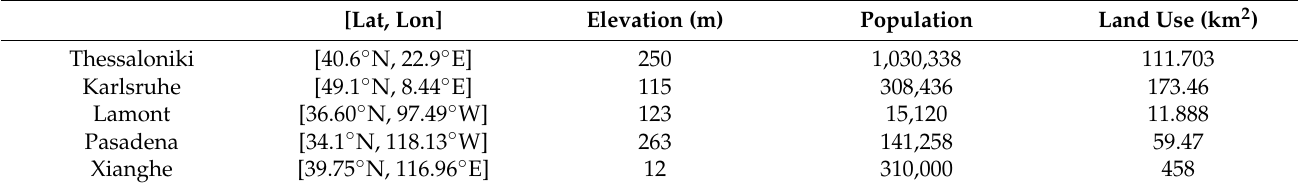
Table 2. Site features of Pasadena, Lamont, Karlsruhe, Thessaloniki and Xianghe are listed in the table